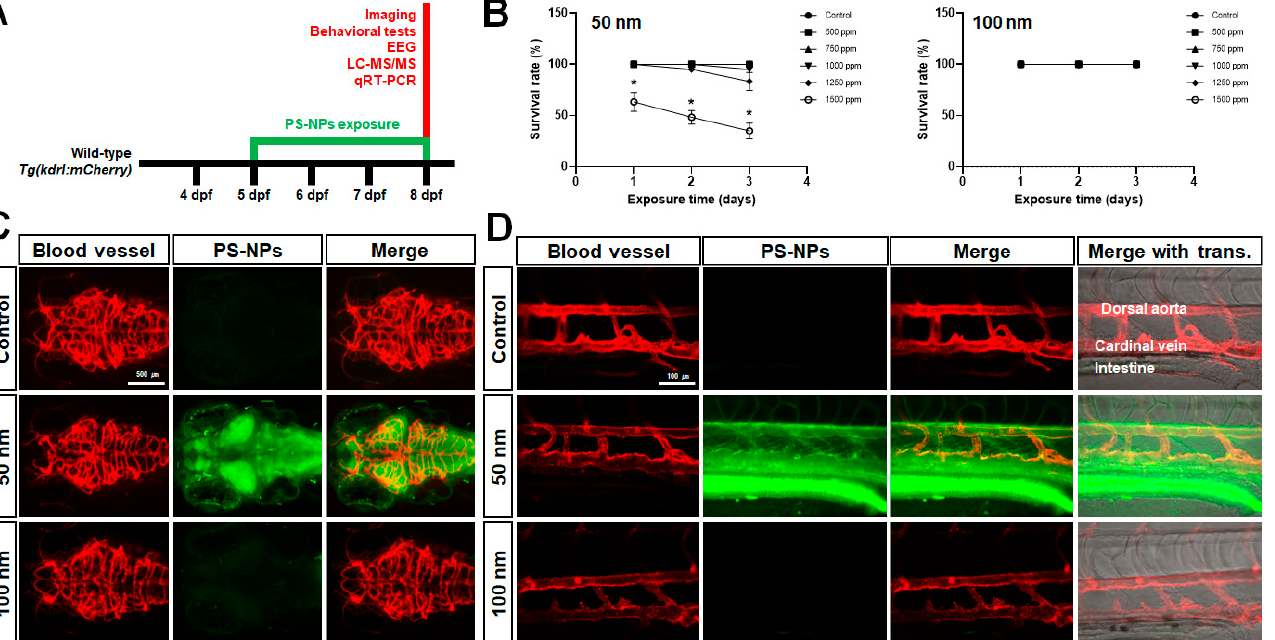
Figure 1. Accumulation of polystyrene nanoparticles (PS-NPs) in zebrafish larvae. ( A ) Experimental scheme of PS-NPs-exposed zebrafish larvae. ( B ) Survival test in PS-NPs-exposed zebrafish larvae. Representative images of the brain ( C ) and the posterior trunk region ( D ) in 1000 ppm of PS-NPs- exposed Tg(kdrl:mCherry) ; mitfa − / − . Red and green fluorescence indicate the blood vessel and accumulated PS-NPs in the brain ( C ) and the posterior trunk ( D ), respectively. Data sets were expressed as the means ± standard error of the mean and statistical significance was set at 0.05, 0.01, and 0.001 (* p ≤ 0.05).